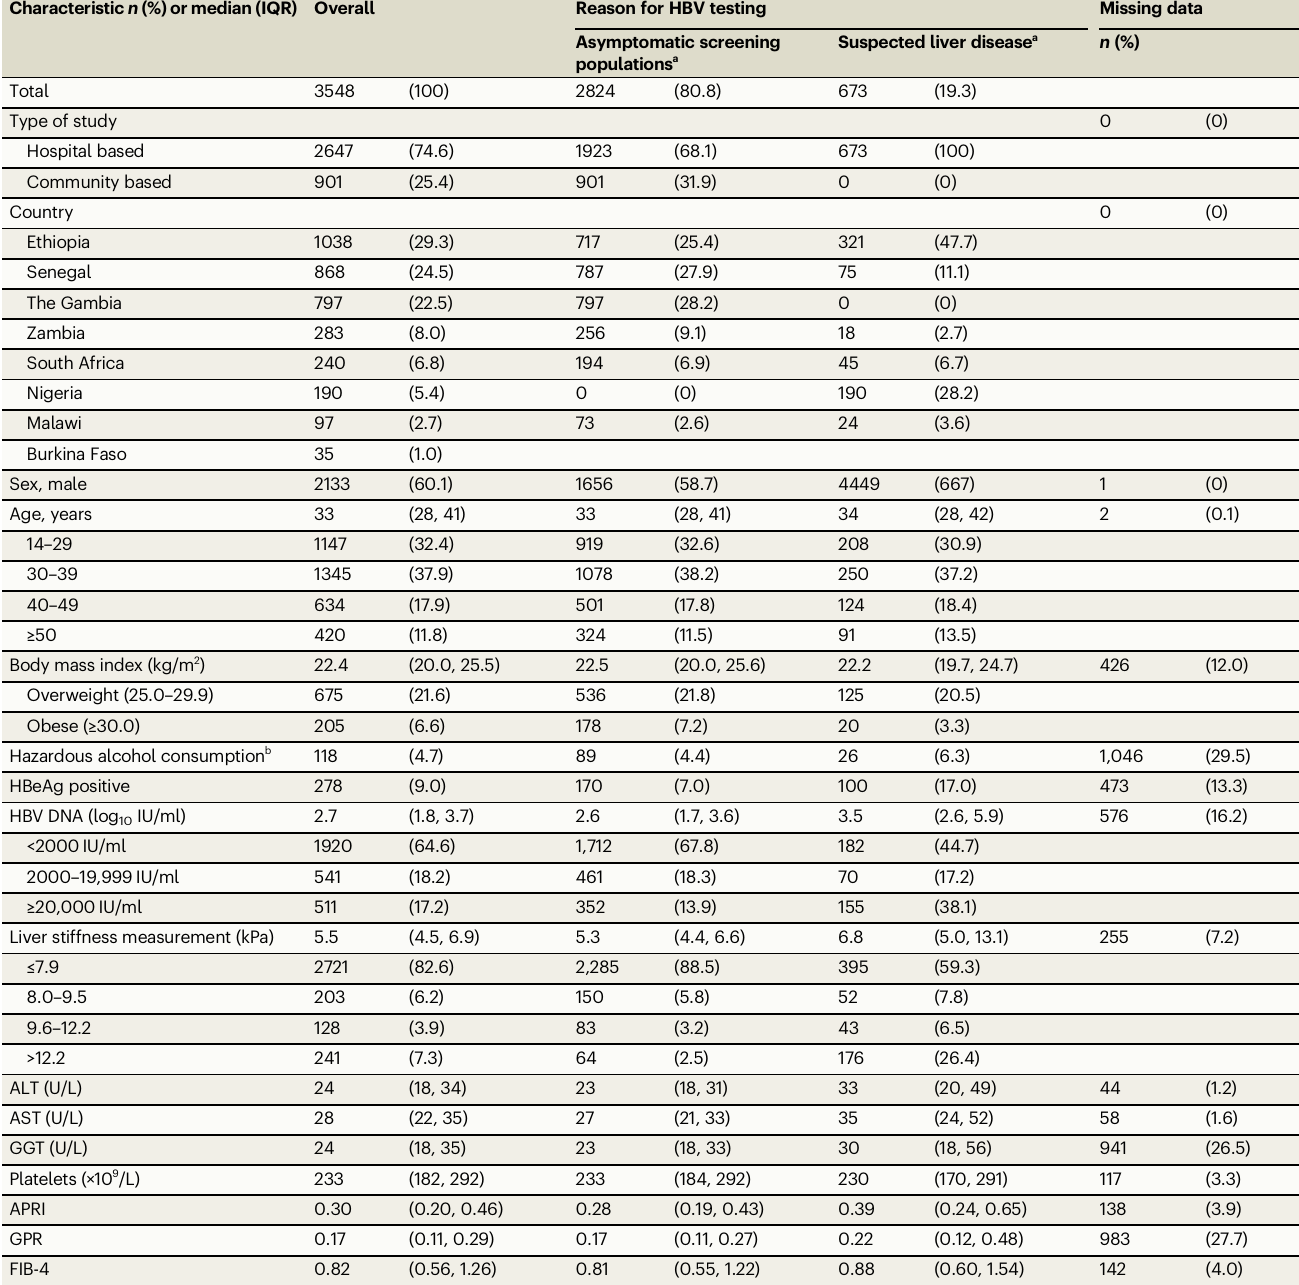
Table 1 | Characteristics of study participants Characteristic n (%)ormedian(IQR) Overall Reason for HBV testing Missing data